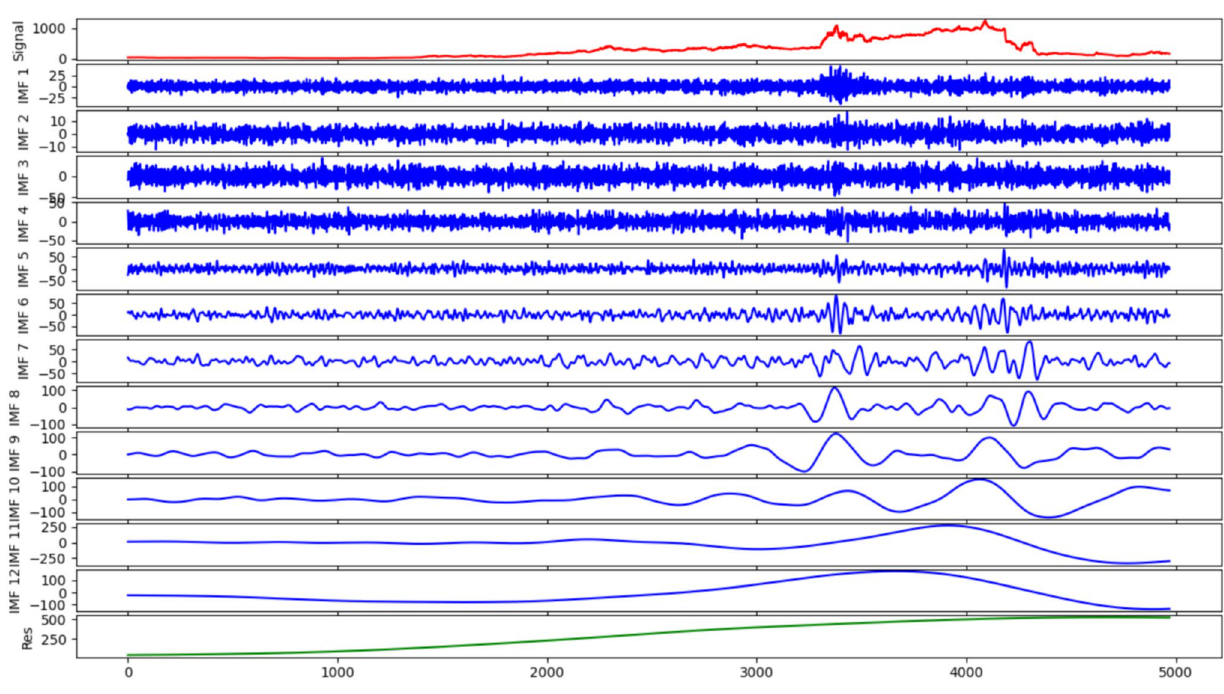
Fig. 3 The decomposition results of CEEMD for